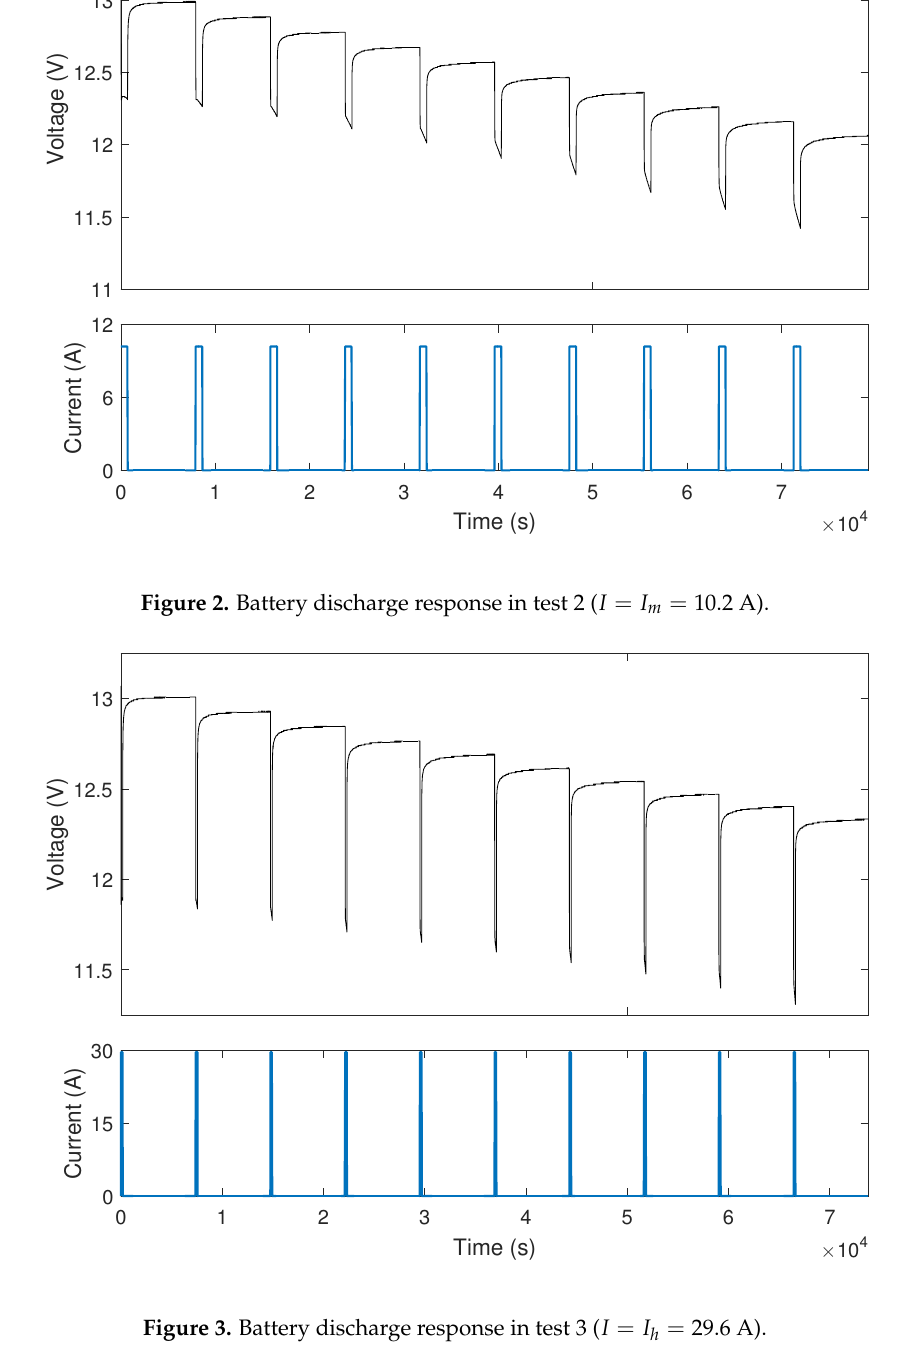
Figure 3. Battery discharge response in test 3 ( I = I h = 29.6